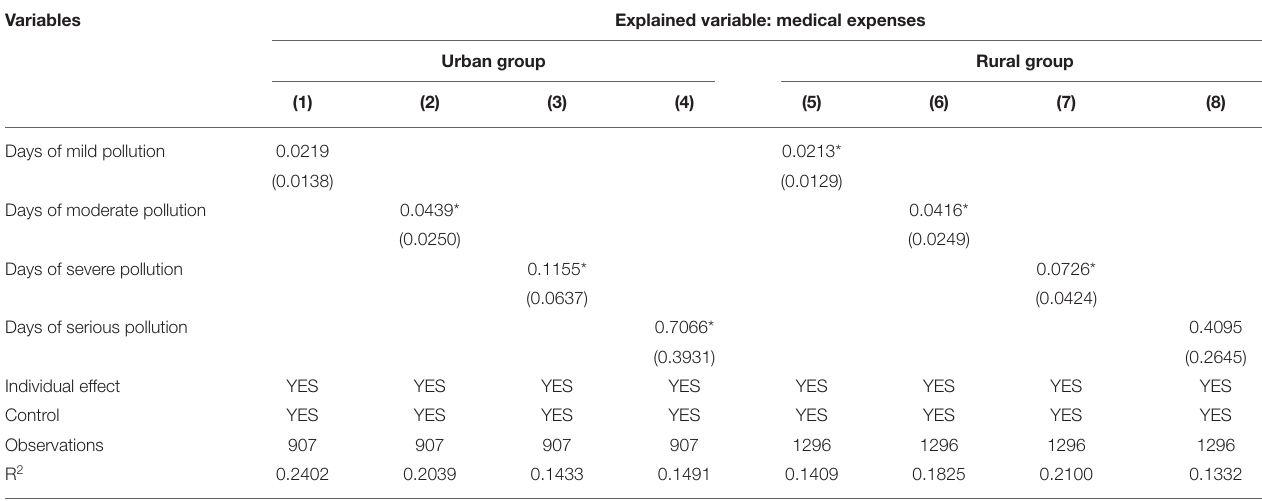
TABLE 7 | Urban and rural heterogeneity: air pollution and medical